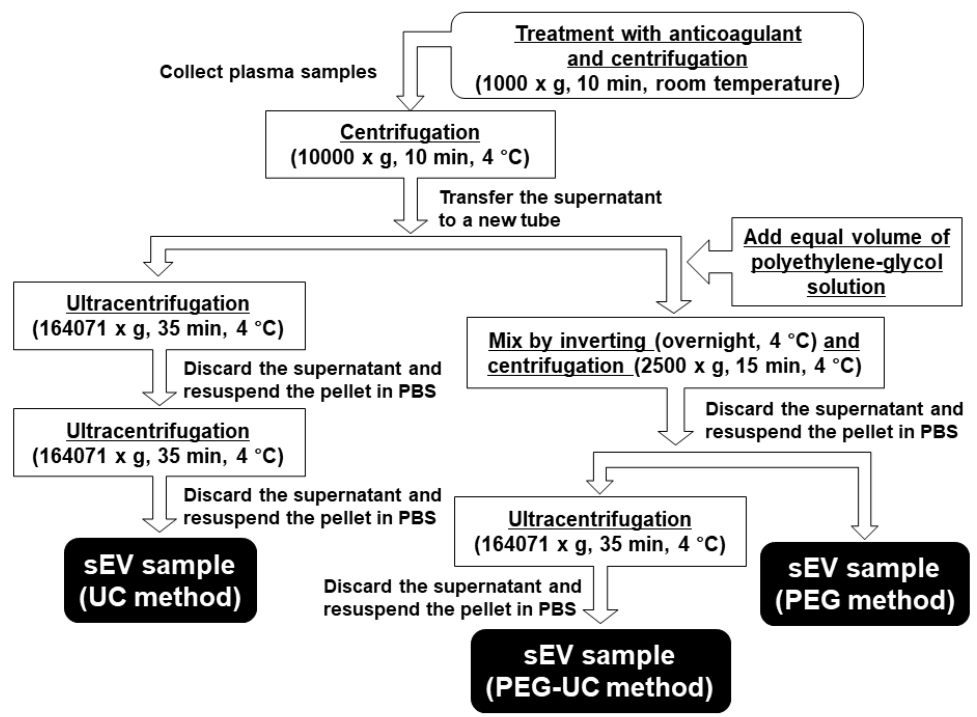
Figure 1. Scheme of isolation procedures for small extracellular vesicles (sEVs) derived from rat plasma. Blood samples were obtained from male Wistar rats (7–9-week-old) via an inferior vena cava under anesthetization with urethane (1.5 g/kg, i. p.). Ethylenediaminetetraacetic acid (EDTA, 1